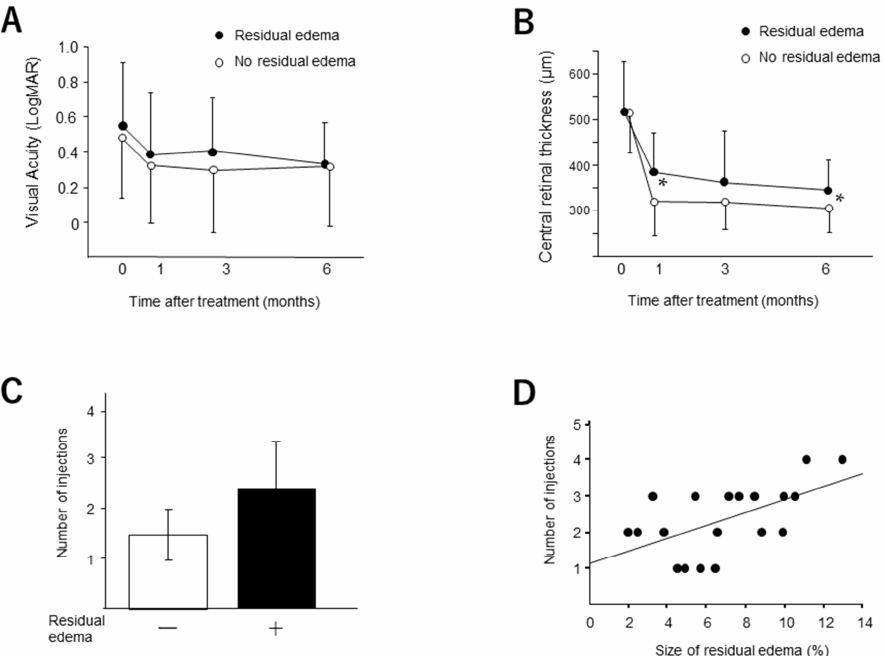
Figure 5. The involvement of the residual edema for anti-VEGF therapy. The changes of visual acuity ( A ) and central retinal thickness ( B ) in the eyes with and without the residual edema were measured at 0, 3 and 6 months. Visual acuity is expressed as logMAR. Data are presented as mean ± standard deviation (SD). * p < 0.05 (versus groups). ( C ) The number of injections of anti-VEGF agent during 6 months. ( D ) The correlation between the number of injections and the size of residual edema after initial injection. Significant correlations were observed ( p = 0.0002, R 2 =0.32).